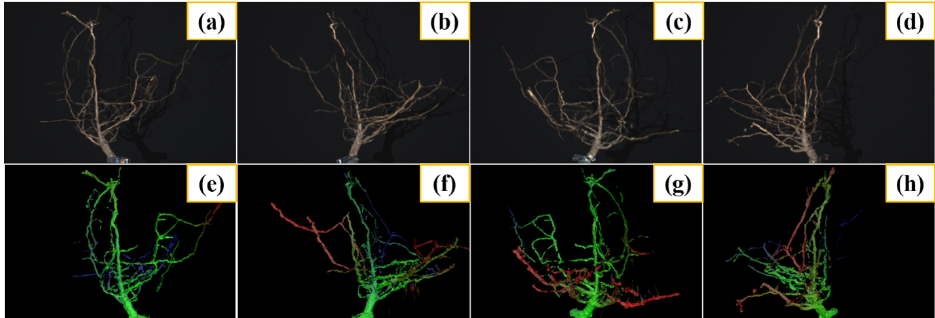
Figure 11. Sample measurement results of soybean roots with complicated morphology using the FPP technology. ( a – d ) photographs of the measured root samples; ( e – h ) corresponding 3D measurement results.